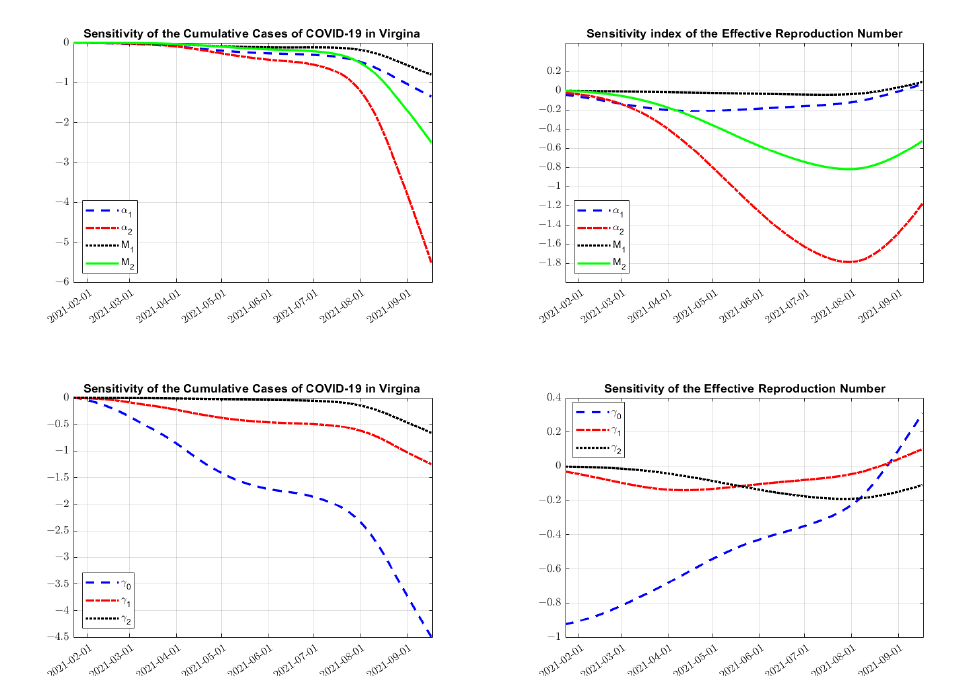
Figure 3. Sensitivity analysis using Equation (11) on the cumulative cases of COVID-19 in Virginia (left column) and R t (the effective reproduction number, right column) with respect to vaccination parameters ( M 1 , M 2 , α 1 , and α 2 ) and recovery rates ( γ 0 , γ 1 , and γ 2 ). Note the negative impact of the parameters on the cumulative cases, but a non-trivial impact on the effective reproduction number as population sizes change in each vaccination stage through time. Further notice the small influence that M 1 has on both outputs, until later in the simulation.